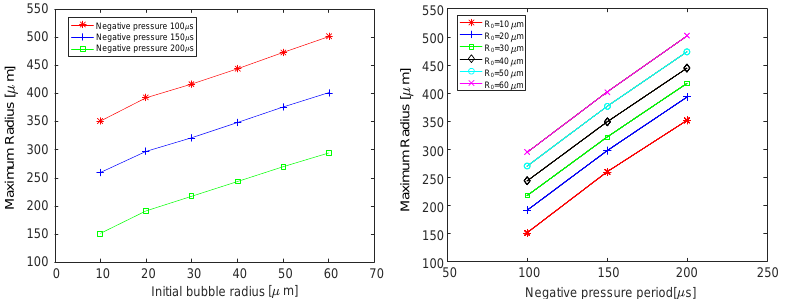
Figure 7. Relation between negative pressure and initial bubble radius on maximum bubble radius at constant standoff distance 1000 µ